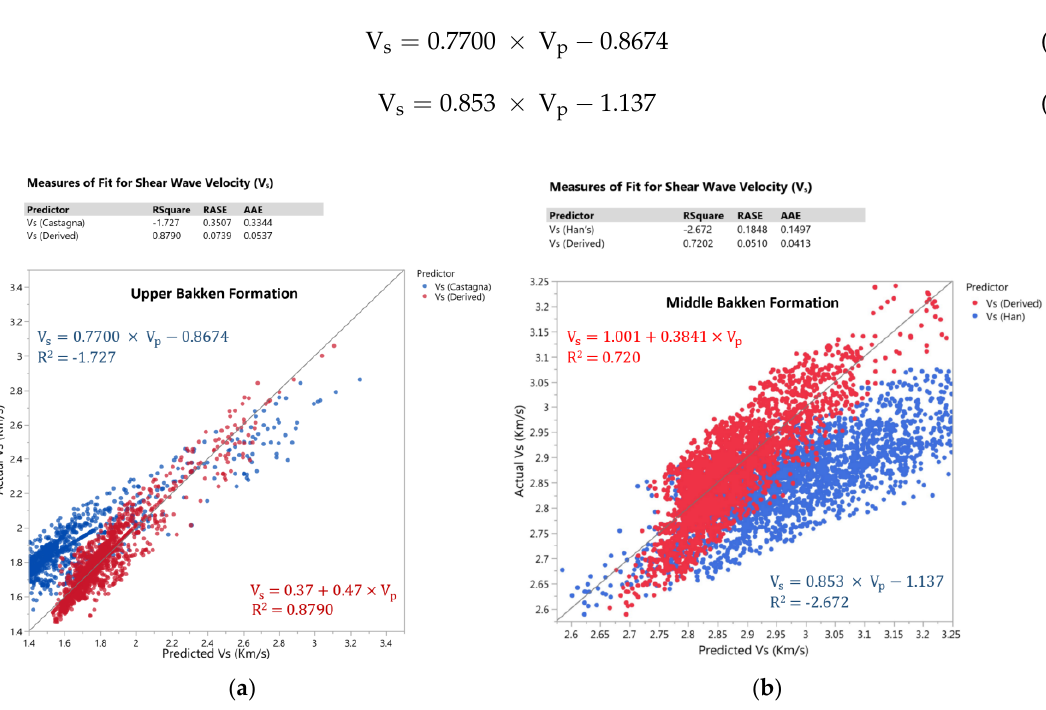
Figure 16. ( a ) Comparison of Upper Bakken Shale’s equation with Castagna’s equation. ( b ) Comparison of Middle Bakken Sandstone’s equation with Han’s equation.